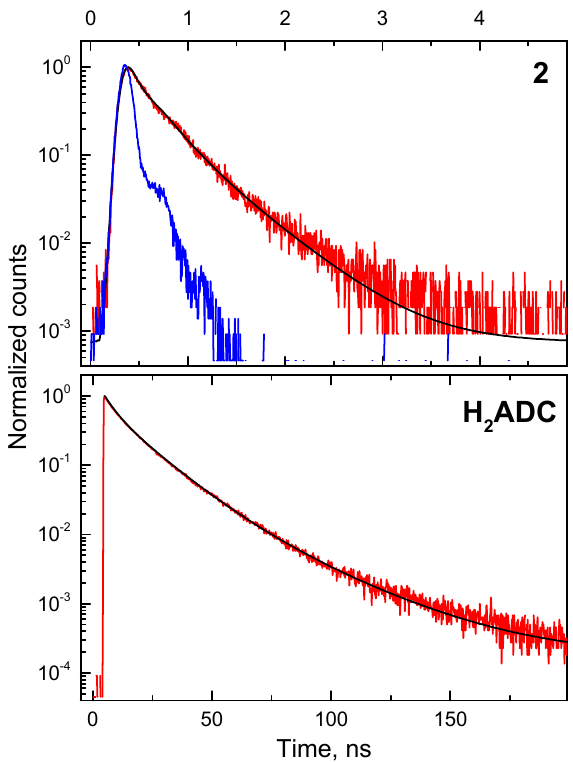
Figure 4. Photoluminescence decay curves of Structure 2 (top graph) and H 2 ADC (blue = IRF, red = experimental data, black solid lines = model fit). (Excitation wavelength = 372 nm).